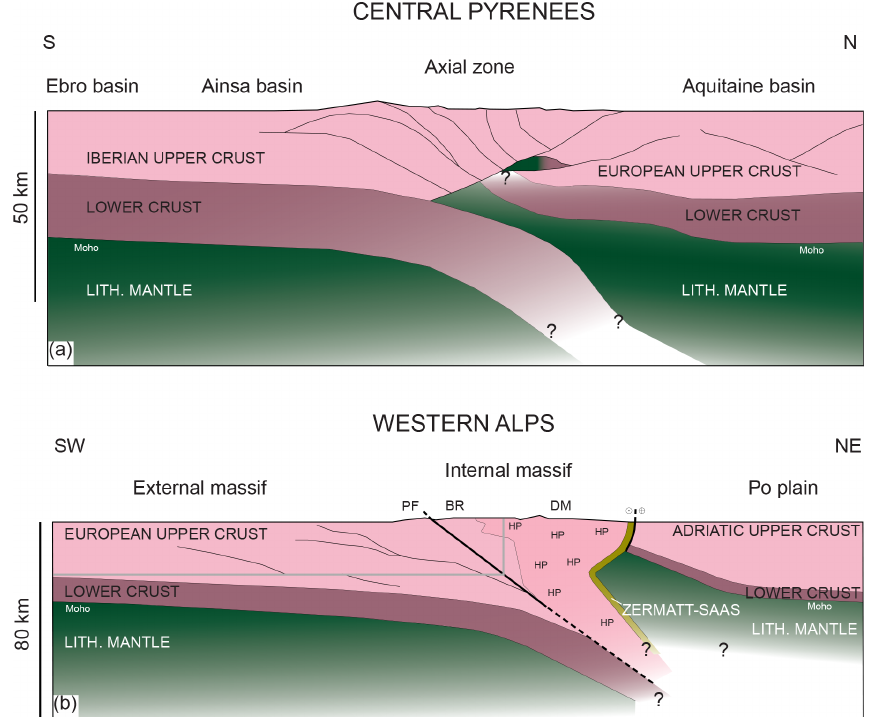
Figure 1. Simplified tectonic cross sections: (a) across the Central Pyrenees, modified after Teixell et al. (2018) and (b) across the Western Alps, modified after Zhao et al. (2015) and Schmid et al. (2017). Light violet represents the upper crust, dark violet represents the lower crust and green represents the mantle lithosphere. The region of mixed violet and green in (a) represents a unit of lower crust or mantle thrust slices. Black lines indicate unit boundaries and the grey line in (b) indicates the domain captured by most crustal wedge models (compare to Malavieille, 2010; Dal Zilio et al., 2020b, for example). Abbreviations: Penninic Front, PF; Briançonnais, BR; Dora–Maira, DM; and high-pressure regions,